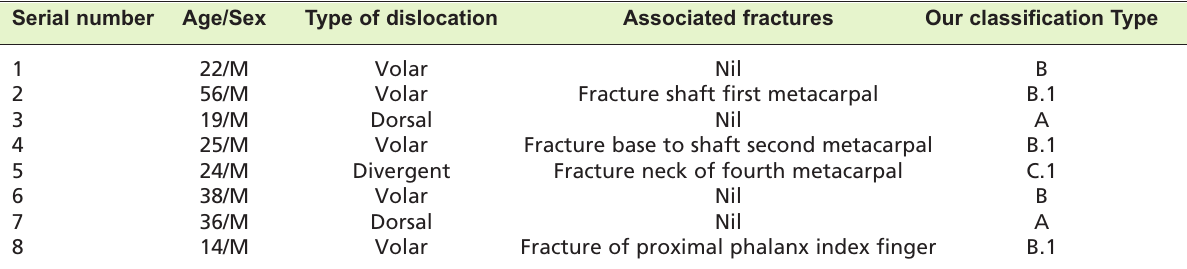
Application of proposed classification in patients in our study Table II: